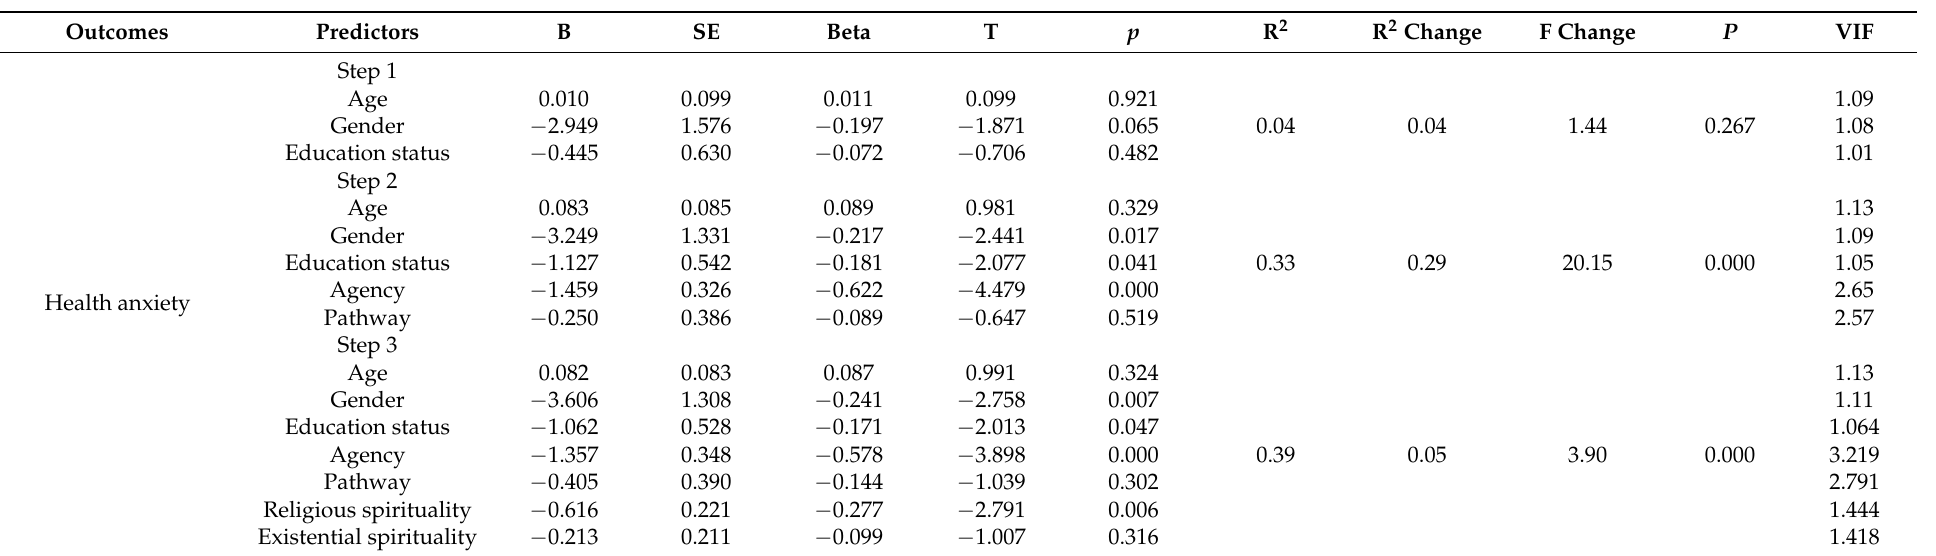
Table 2. Results of hierarchical multiple regressions for hope and spiritual well-being subscales as predictors of health